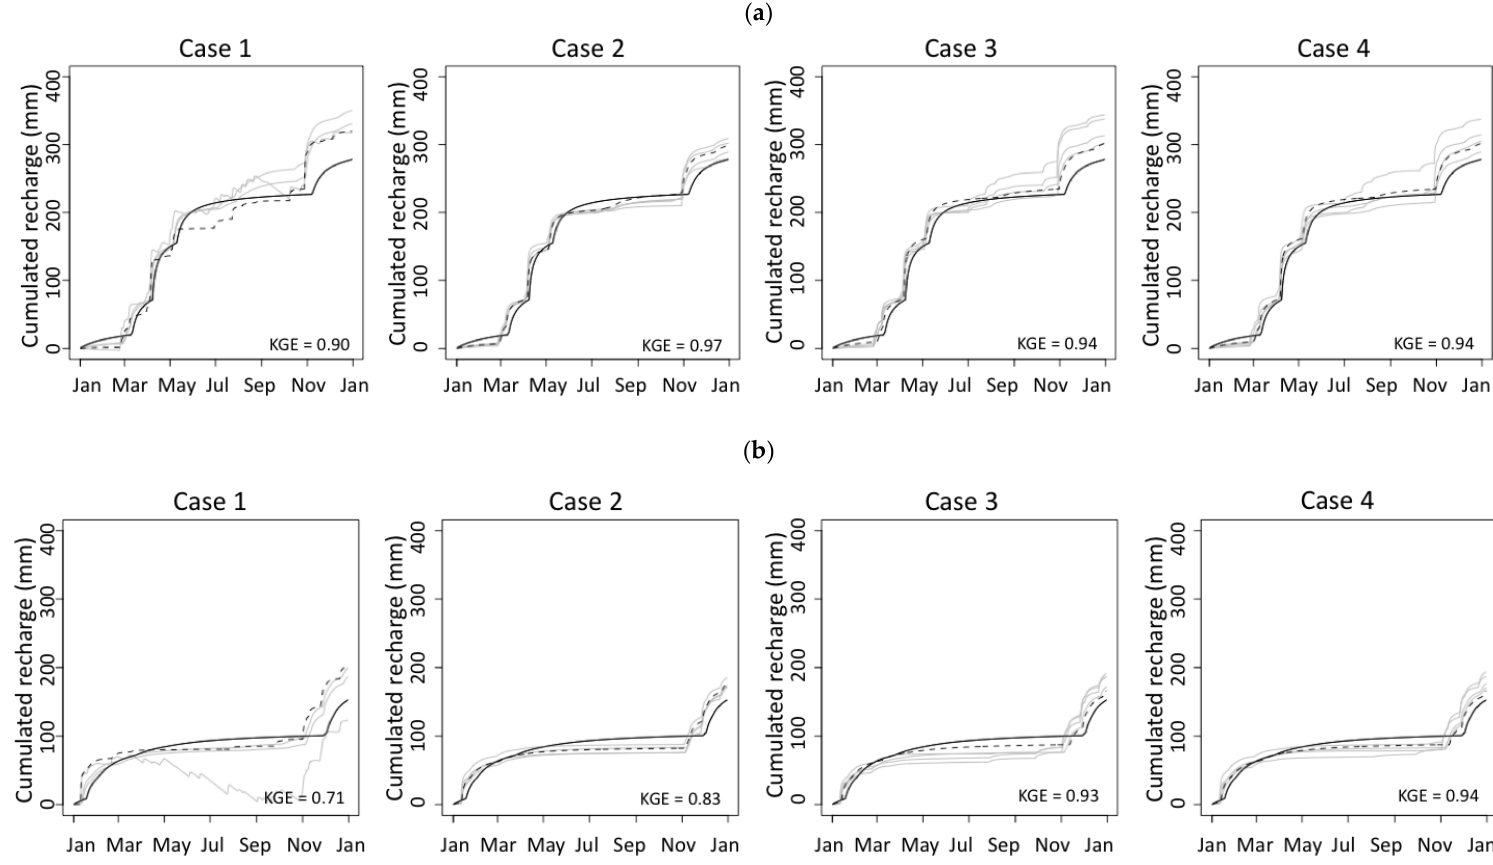
Figure 3. Annual cumulated groundwater recharge values for 2017 ( a ) and 2018 ( b ). Results of the synthetic case are presented as continuous black lines. The five best sets of parameter results are presented as gray lines. Kling–Gupta efficiency (KGE) is calculated for the synthetic case results and the best set of soil hydraulic parameter results (black dashed line).